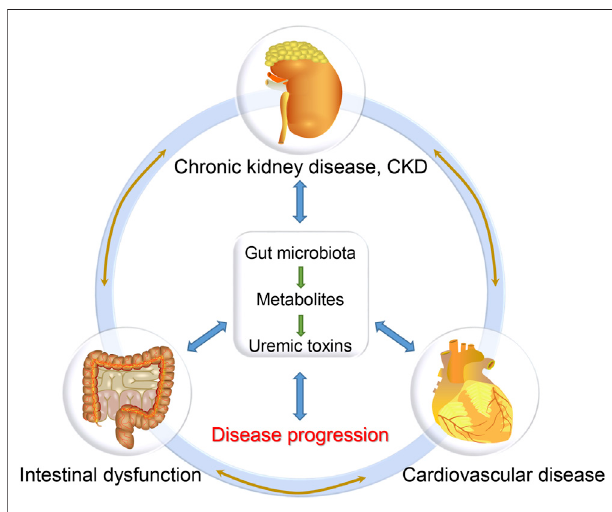
FIGURE 1 | The gut-kidney-heart axis